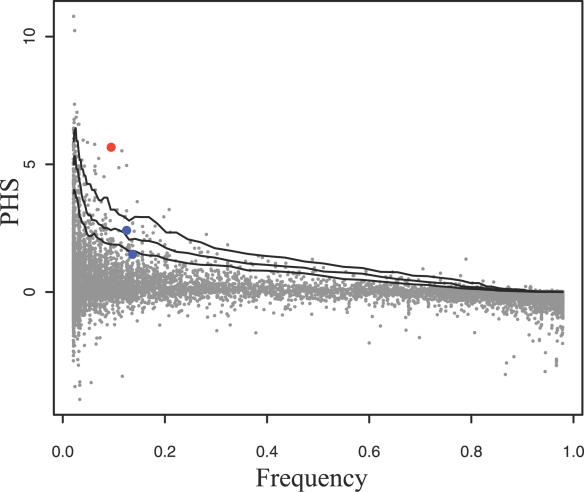
PHS Plotted against Frequency for all Nonredundant Alleles in Our Genome-Wide Dataset (10,961 Alleles)The percentile lines (95th, 97.5th, and 99th) are computed from the respective percentiles (and average frequency) of 100 overlapping sliding windows (100-point offset between adjacent windows) of 1,000 points along the data (sorted by frequency). The
fri
Col allele is shown in red, while the
fri
Ler allele and another allele that marks it are shown in blue.
fri
Ler is the allele below the 95th percentile line.